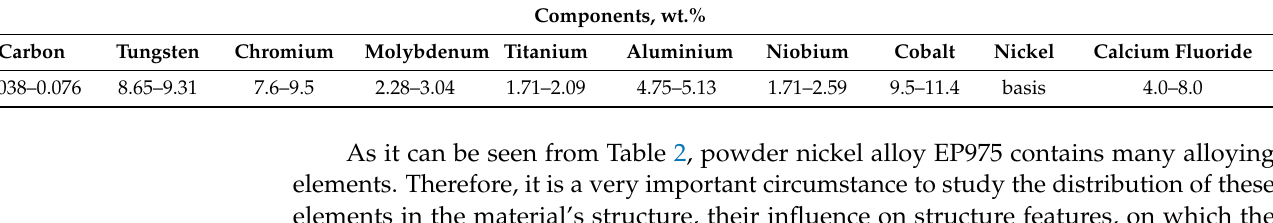
Table 2. Chemical Composition of the Materials Based on Powder Nickel Alloy EP975. Components,